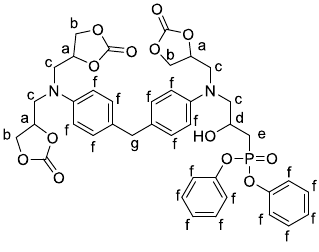
Figure 15. MBDAC-DPP structure.